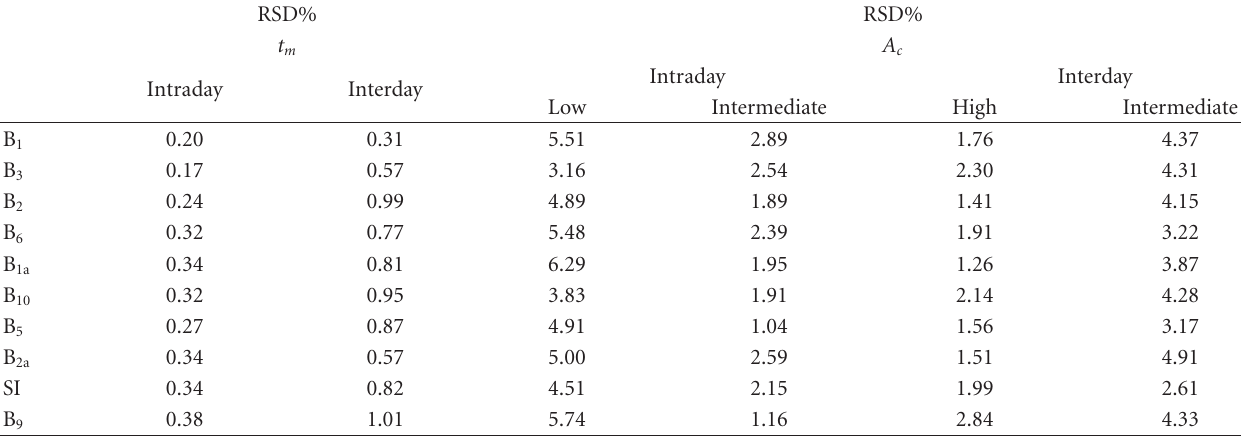
Table 1: Intraday and interday precision of migration time ( t m ) and corrected peak area ( A c ) in optimal condition at low-, intermediate-, and high-concentration levels.